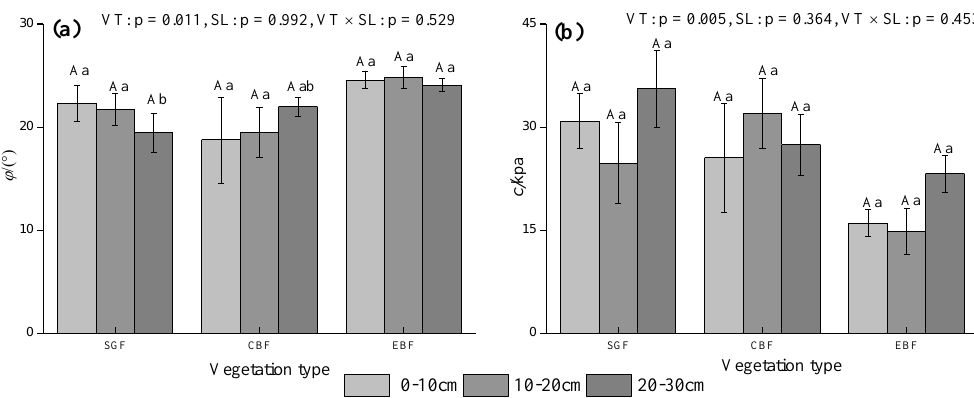
Figure 4. Change law of shear strength parameters of three vegetation types and three soil layers (mean ± SE, n = 4), SE is the variance of the index. The error line indicates standard error; the upper case letter indicates a significant difference among different soil layers of the same land use types ( p < 0.05); lower case letters indicate a significant difference between different land use types of the same soil layer ( p < 0.05). EBF stands for evergreen broad-leaved forest; CBF stands for mixed forest; SGF stands for shrub-grass forest; φ stands for internal frictional angle; c stands for cohesive force; VT stands for vegetation type; SL stands for soil layer. Two-way ANOVA was applied to indicate significant differences among variances. ( a ) shows the φ in different soil layers in different stands; ( b ) shows the c in different soil layers in different stands.